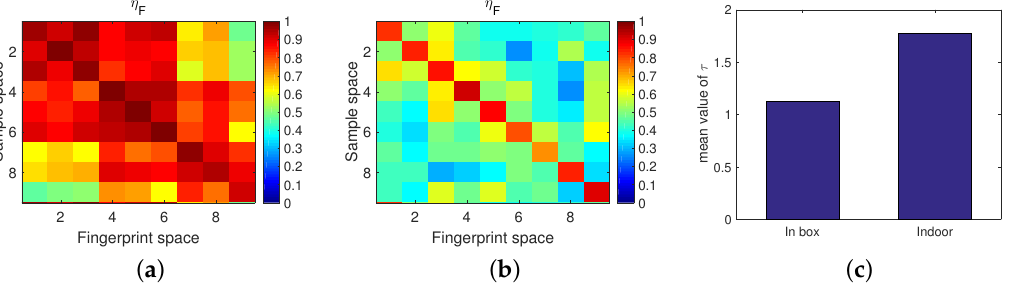
Figure 7. Influence of the multipath component on performance. ( a ) Indoors. ( b ) In the box. ( c ) Spatial-temporal focusing metric